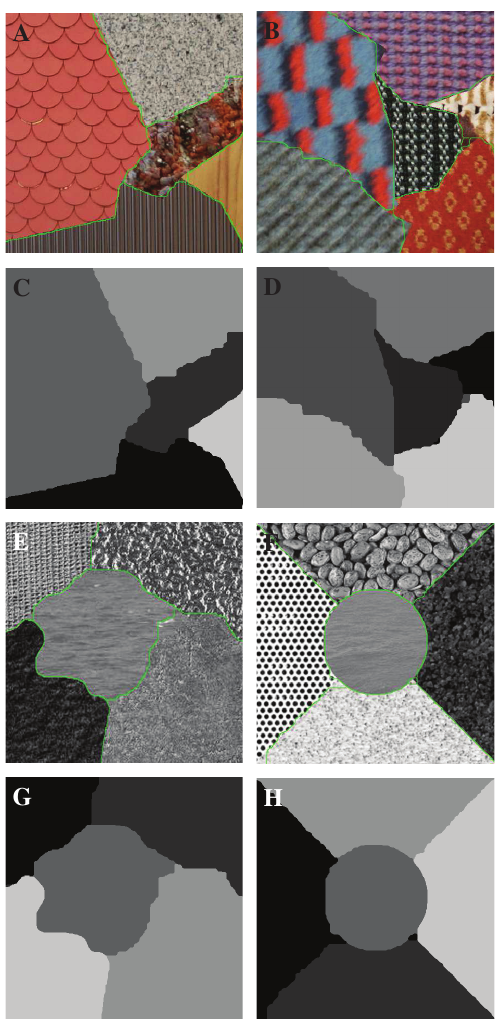
Figure 2. Texture Mosaics: (A, B, E, F) Input Image with Superimposed Segmented Boundaries. (C, D, G, H) Corresponding Segmentation Label